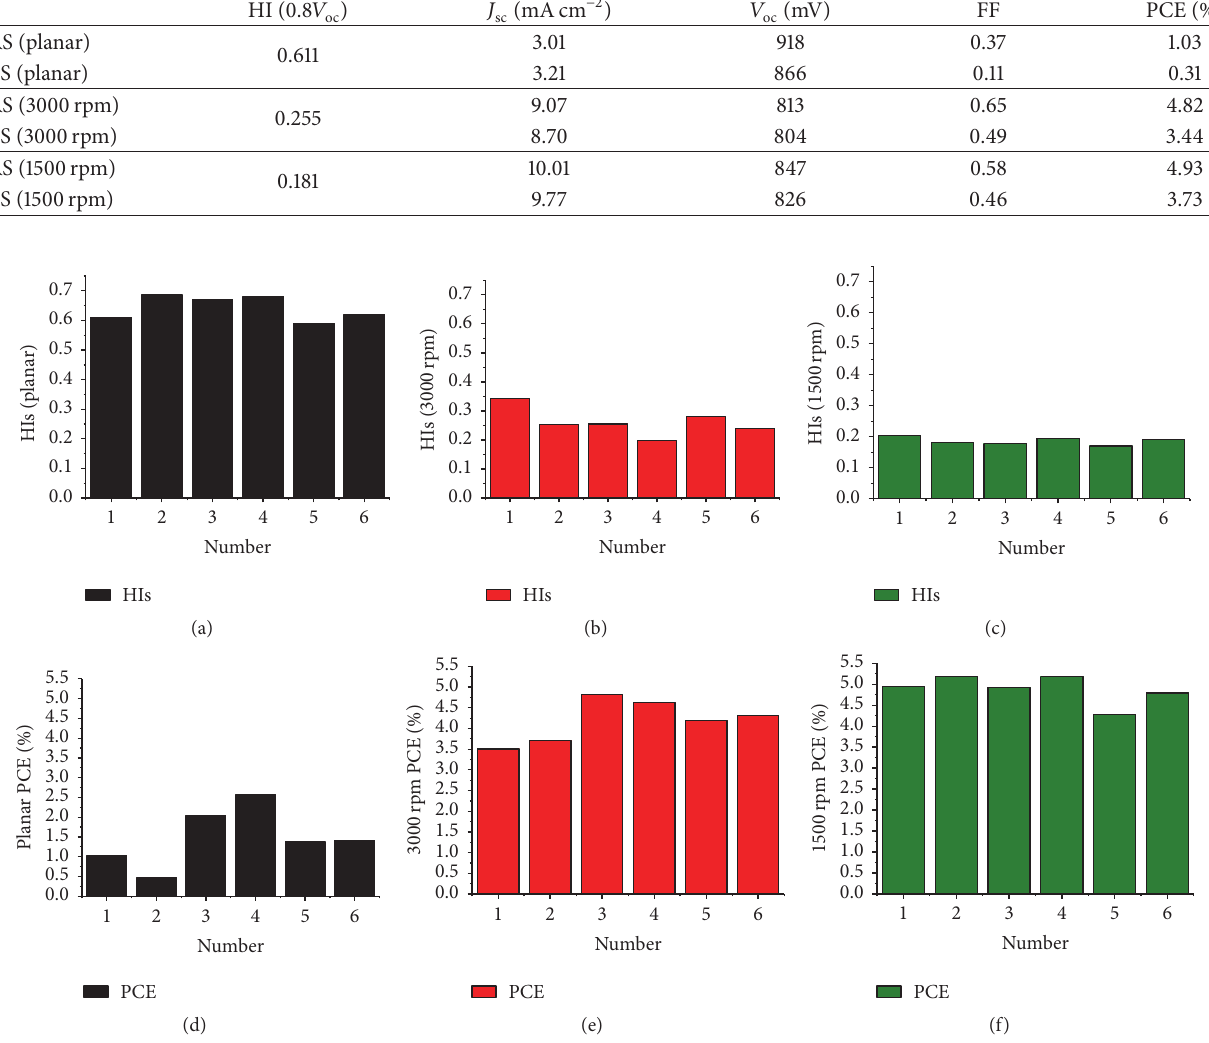
Table 1: Solar cell performance parameters w/o mp-TiO 2 layer or with the spin-coating rates of the mp-TiO 2 precursor for 3000 rpm and 1500 rpm.